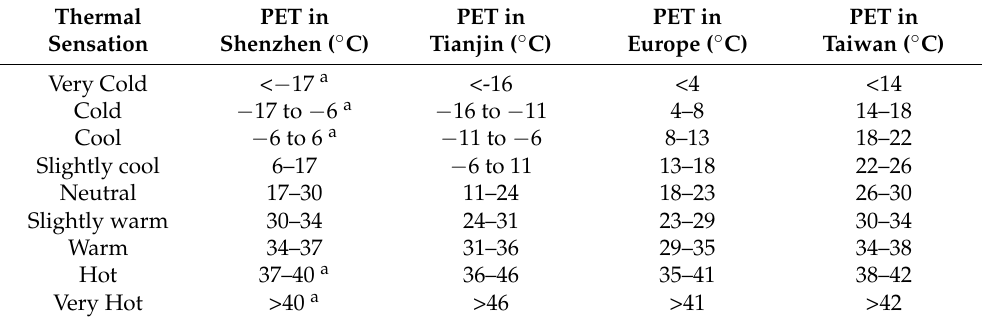
Table 15. Relationship between TSV and PET for Shenzhen, Tianjin residents, Europeans, and Taiwanese.